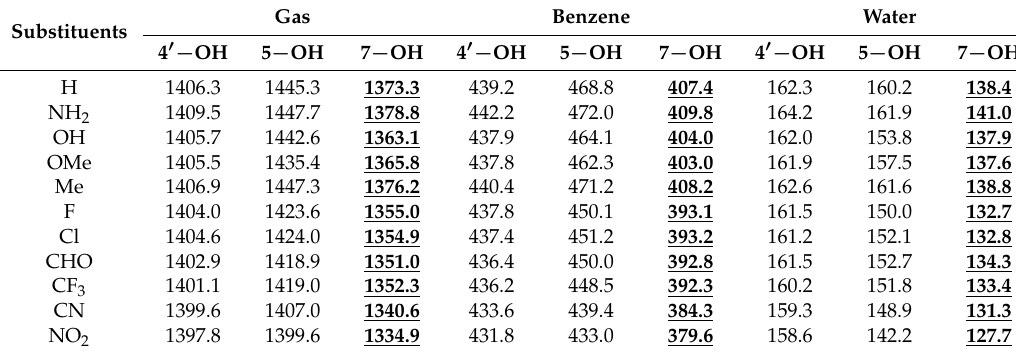
Table 3. Proton affinity (PA) in kJ/mol obtained by the M062X/6-311+G** method. The data in the form of the bold and underline represent the lowest PAs in the